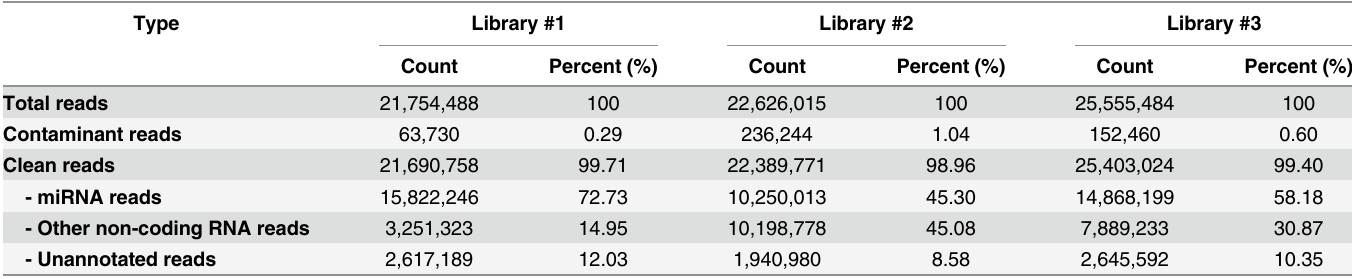
Table 1. Sequencing read statistics for small RNA libraries of horse